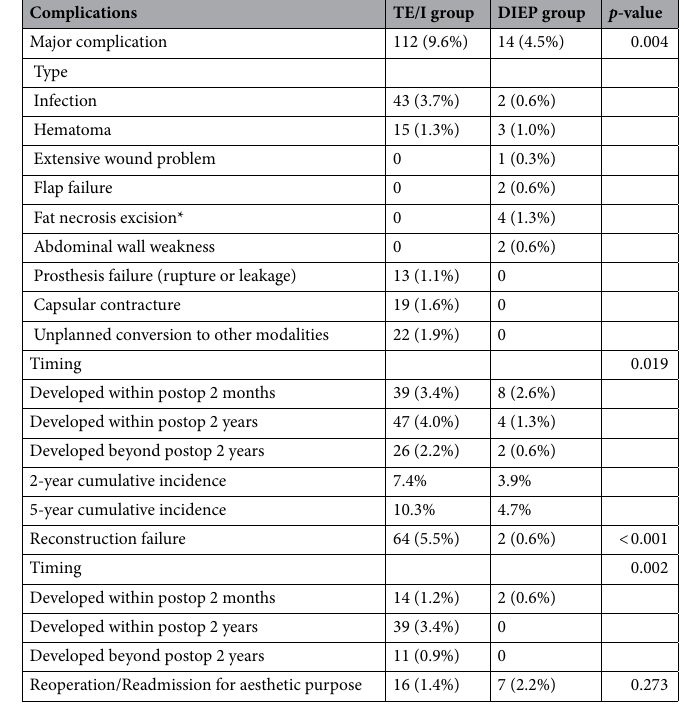
Table 2. Comparison of outcomes between two groups. All analyses were conducted with the first event occurred during the follow-up period. *The fat necrosis was a kind of partial flap necrosis that could be derived from insufficient perfusion to the flap adipose tissue. Excision of fat necrosis was conducted in patients who developed palpable nodules over 2 cm in diameter on their reconstructed breasts and wanted to remove the lesions.